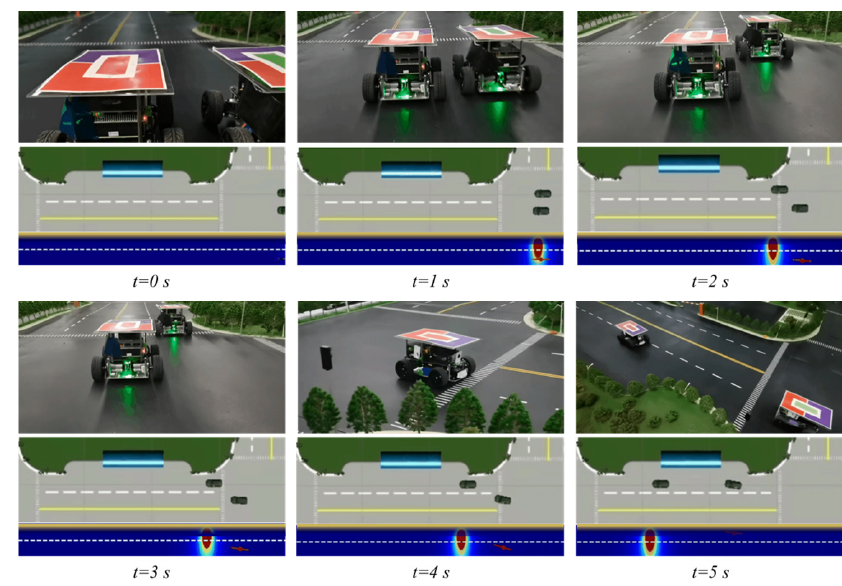
Figure 19. An example case of Sicity platform for real ‐ world experiments.